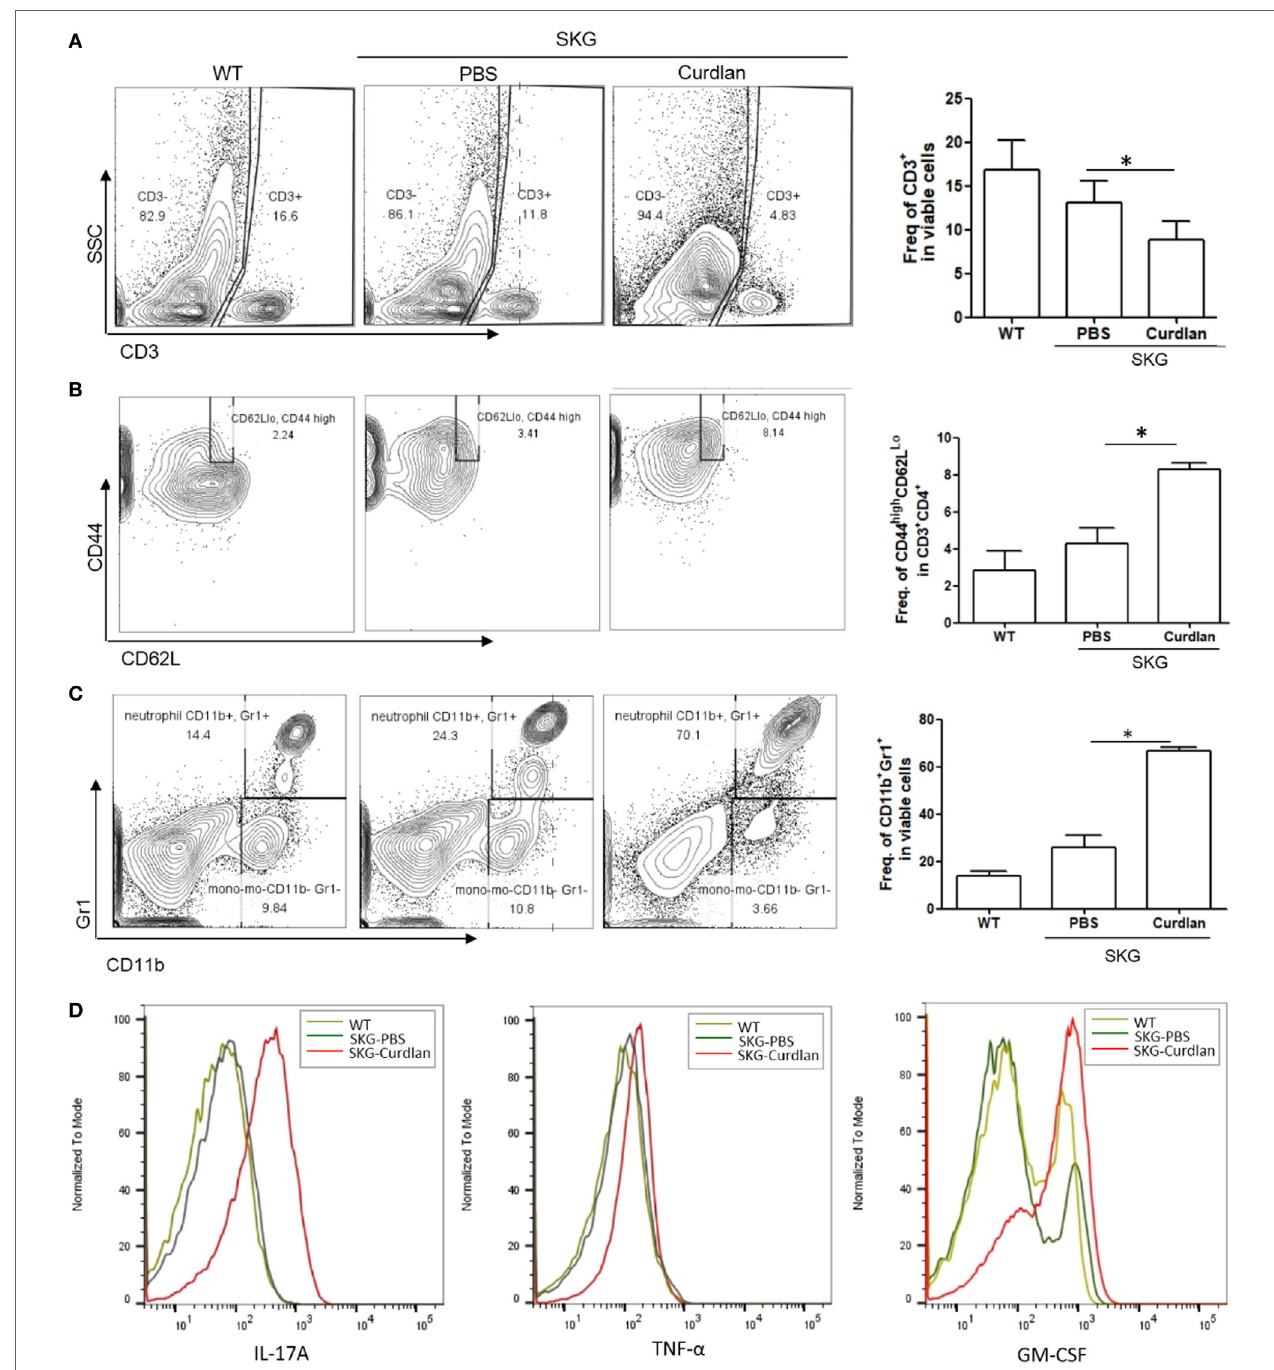
FigUre 2 | Neutrophils in the lungs of curdlan-treated SKG mice. Flow cytometry plots showing (a) proportion of CD3 + cells among lung-infiltrating cells, (B) proportion of CD44 high CD62L Lo cells among CD3 + CD4 + cells, and (c) proportion of G11b + Gr1 + cells among lung-infiltrating cells. (D) Levels of IL-17A, TNF- α , and GM-CSF in lung-infiltrating cells. Values in (a–c) are mean ± SEM. * p < 0.05 by Mann–Whitney U